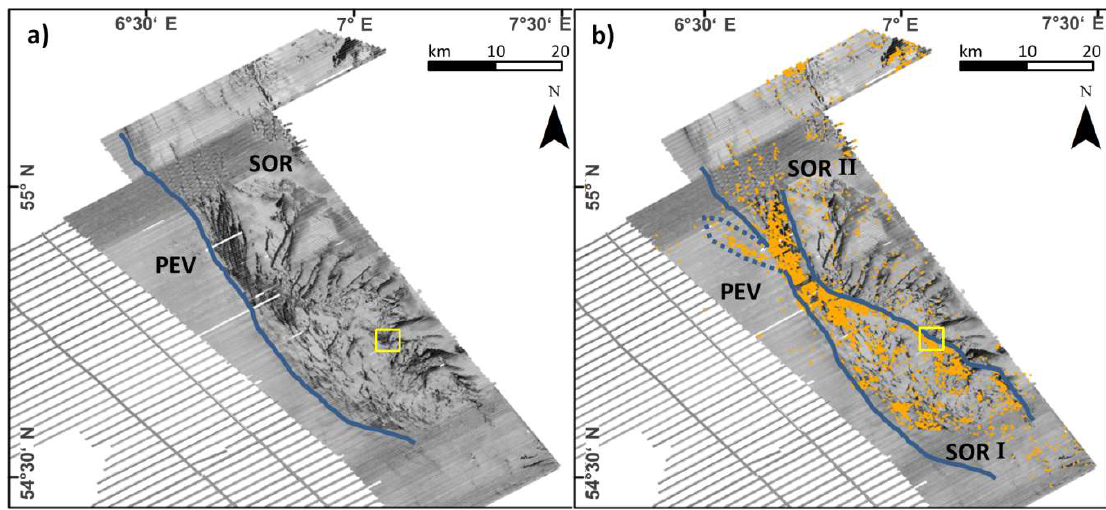
Figure 2. ( a ) Backscatter mosaic showing two sedimentologically different areas: “PEV” (paleo Elbe valley) with homogeneously distributed muddy fine sands and “SOR” (Sylt Outer Reef) with small-scale changes of fine sands and coarse sediments. Yellow box shows the location of the case study area. ( b ) Backscatter mosaic with positions of hyperbolas retrieved from the parametric sediment echo sounder data. Based on that, the SOR can be divided in a more stony (SOR I) and a more gravelly (SOR II) area. The PEV reveals low backscatter data representing muddy fine sands (mean 100 µm). The SOR located east of the valley shows small-scale changes of high, medium and low backscatter.